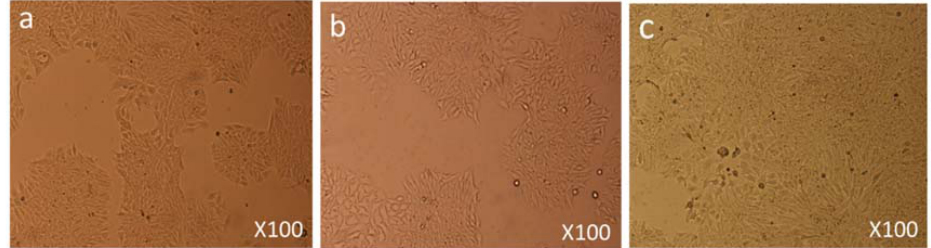
Figure 3. Cell Morphology: The MCF ‐ 7 cells showing morphology ( a ) control (non ‐ treated), ( b ) treated with FMSP ‐ nanoparticles (1.25 μ g/mL) for 6 h, ( c ) treated with FMSP ‐ nanoparticles (1.25 μ g/mL) for 24 h. FMSP ‐ nanoparticles ‐ treated cells did not show any morphological changes when compared to control group cells. 100× magnification.